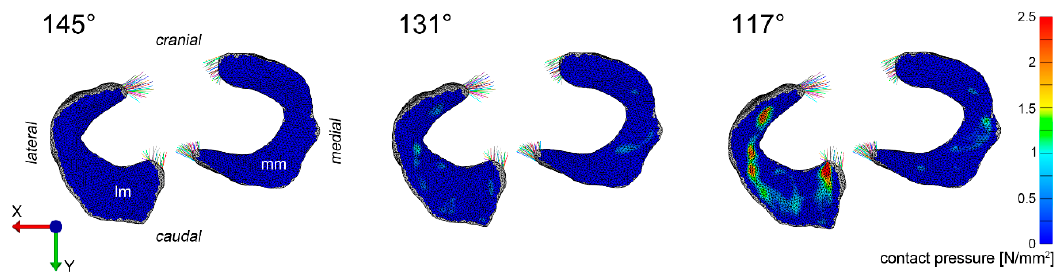
Figure 2. Pressure distribution maps depicting contact pressure on the medial and lateral meniscus. The contact pressure [N/mm 2 ] is visualized for both menisci at 145°, 130° und 117°. Lm = lateral meniscus, mm = medial